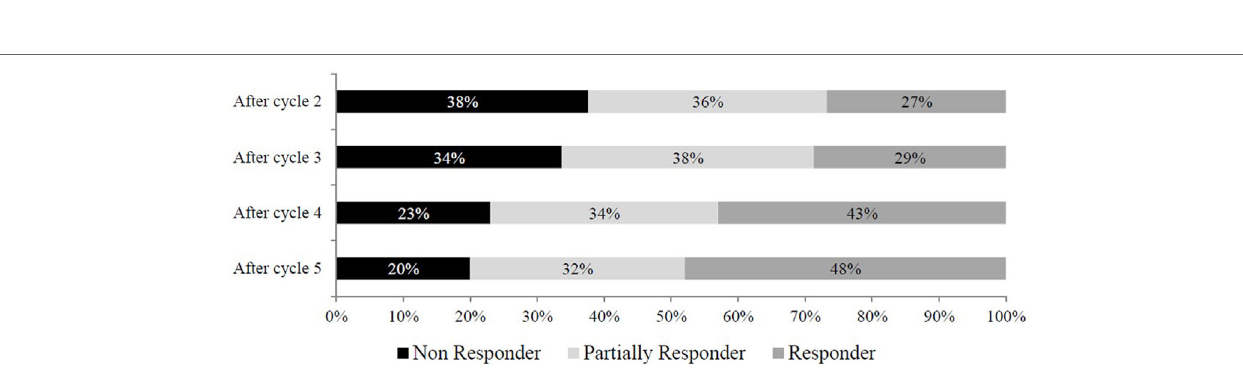
FigUre 2 | Evolution over treatment cycles of the response to onabotulinum toxin A treatment. Non responder: patients with a reduction of days with headache per month < 30%; partially responder: patients with a reduction of days with headache per month between 30 and 49%; responder: patients with a reduction of days with headache per month ≥ 50%.